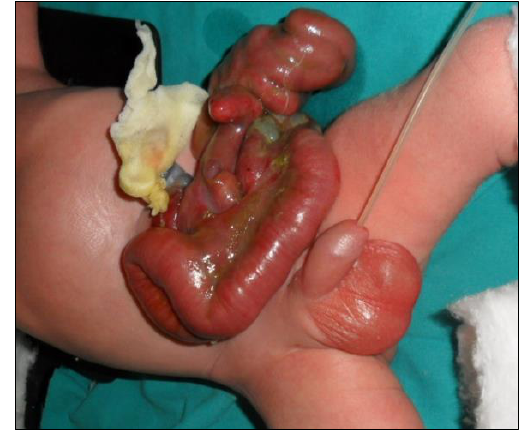
Figure 1: Gastroschis with concomitant jejuno- ileala tresia type III